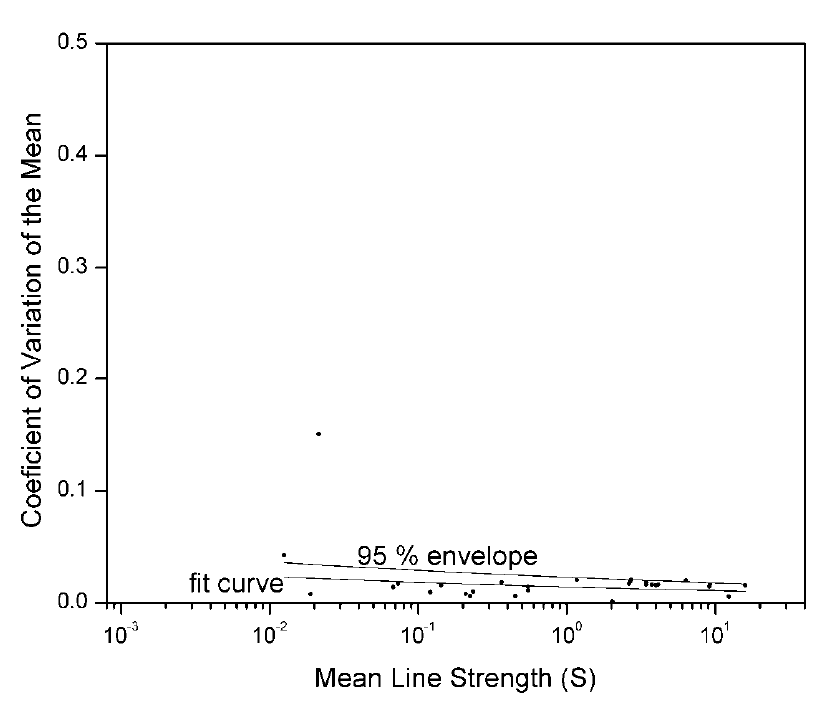
Figure 3. Coefficient of Variation of the mean ( (cid:1829) (cid:3023)(cid:3041) ) for radiative transitions in Na III in which the energy of the upper level is less than 415,000 cm − 1 , in contrast to Figures 1 and 2. One value was weighted as an outlier. Each point is the (cid:1829) (cid:3023)(cid:3041) for a different radiative transition. These data were taken from the same sources as in Figure 2, and the scales are the same. Ninety-five percent of the points lie beneath the upper curve, for which β = 13.8 = 2.3 × 10 − 19 and (cid:1876)̅ (cid:2869)/(cid:2870)